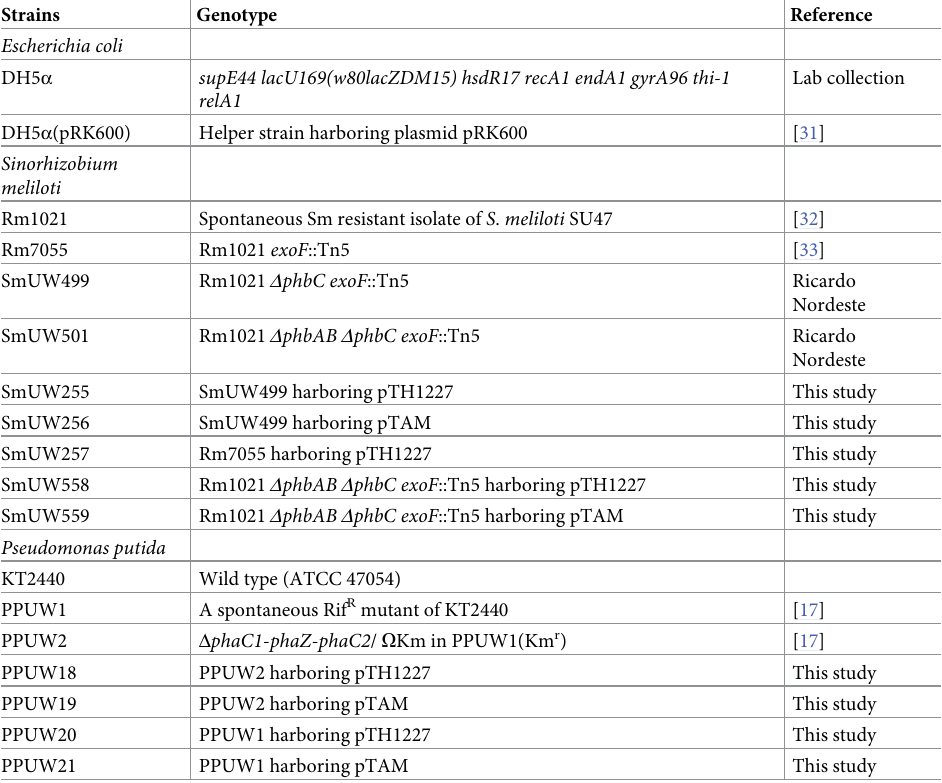
Table 1. Bacterial strains used in this study. Strains